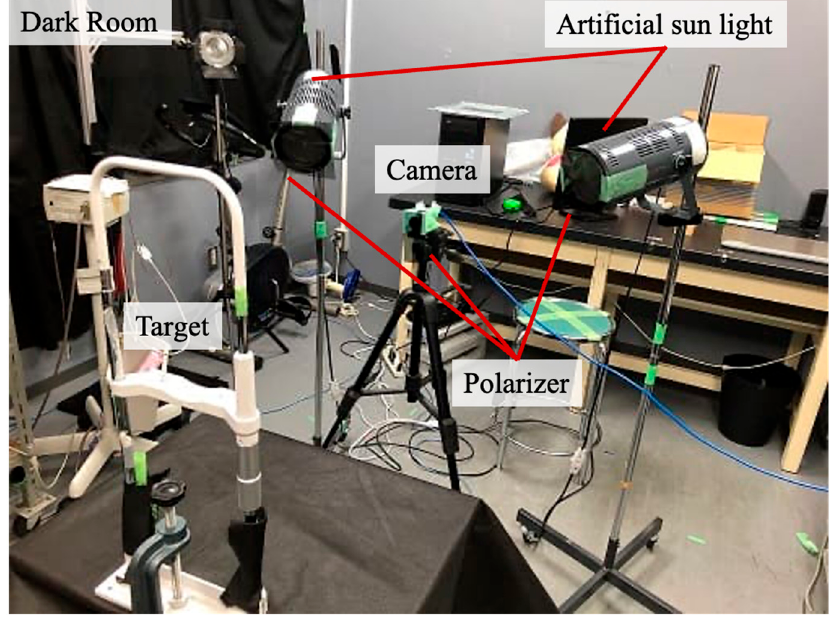
Figure 6. Experimental setup for capturing color patches.